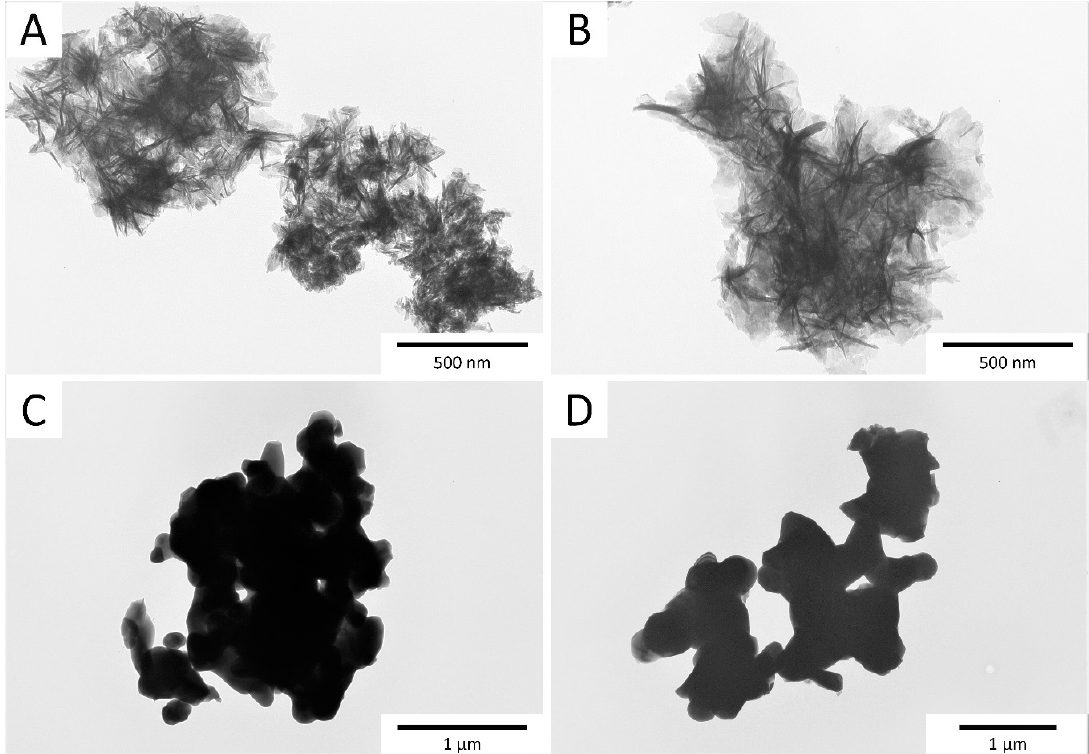
Figure2. TEMimagesoftheanalyzedsamples: ( A )Mn,SiO 4 -HAw, ( B )Mn,SiO 3 -HAw, ( C )Mn,SiO 4 -Had, Figure 2. TEM images of the analyzed samples: ( A ) Mn,SiO 4 -HAw, ( B ) Mn,SiO 3 -HAw, ( C ) Mn,SiO 4 - and ( D ) Mn,SiO 3 Had, and ( D ) Mn,SiO 3 -HAd.